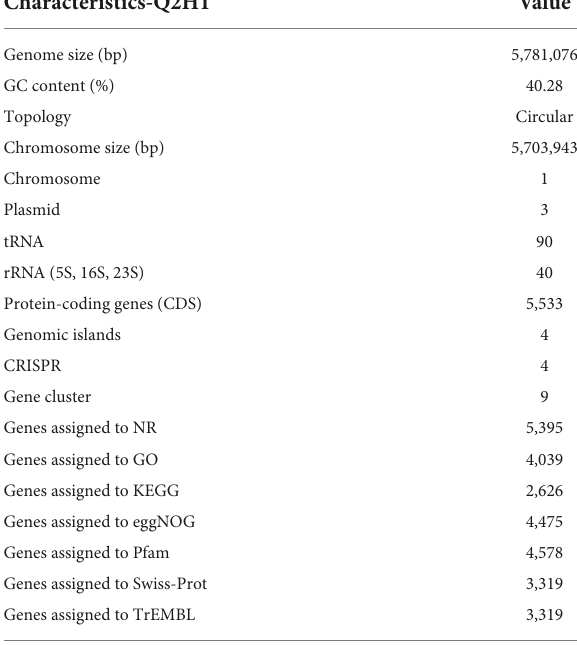
TABLE 1 Genome characteristics of endophytic strain